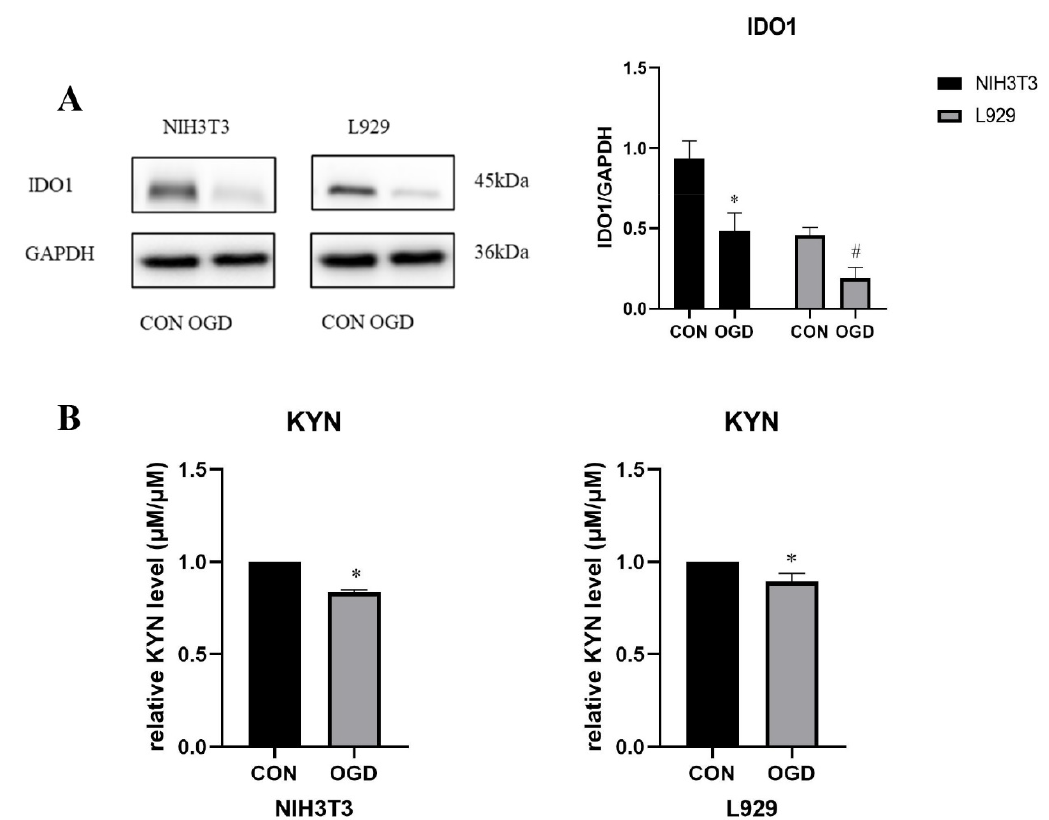
Figure 7. OGD inhibits fibroblast IDO1/KYN. ( A ) Western blot analysis and densitometric analysis of indoleamine 2,3-dioxygenase 1 (IDO1) protein levels in NIH3T3 and L929 cells; GAPDH was used as the loading control. The results are presented as the means ± SDs, and Student’s t -test was used to determine the p -value. * p < 0.05, compared with CON group in NIH3T3 cells; # p < 0.05, compared with CON group in L929 cells. ( B ) The relative kynurenine (KYN) level was detected by Ehrlich assay in NIH3T3 and L929 cells. OGD—oxygen–glucose deprivation; CON—control. The results are presented as the means ± SDs, and Student’s t-test was used to determine the p -value. * p < 0.05, compared with CON group.